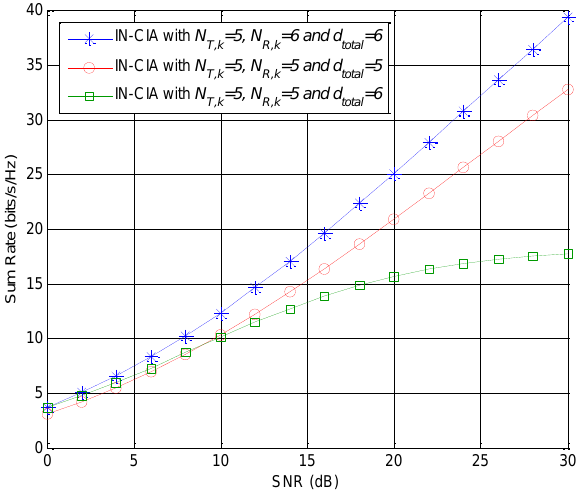
Figure 4. Sum-rate comparison with different numbers of data streams and antenna configurations.